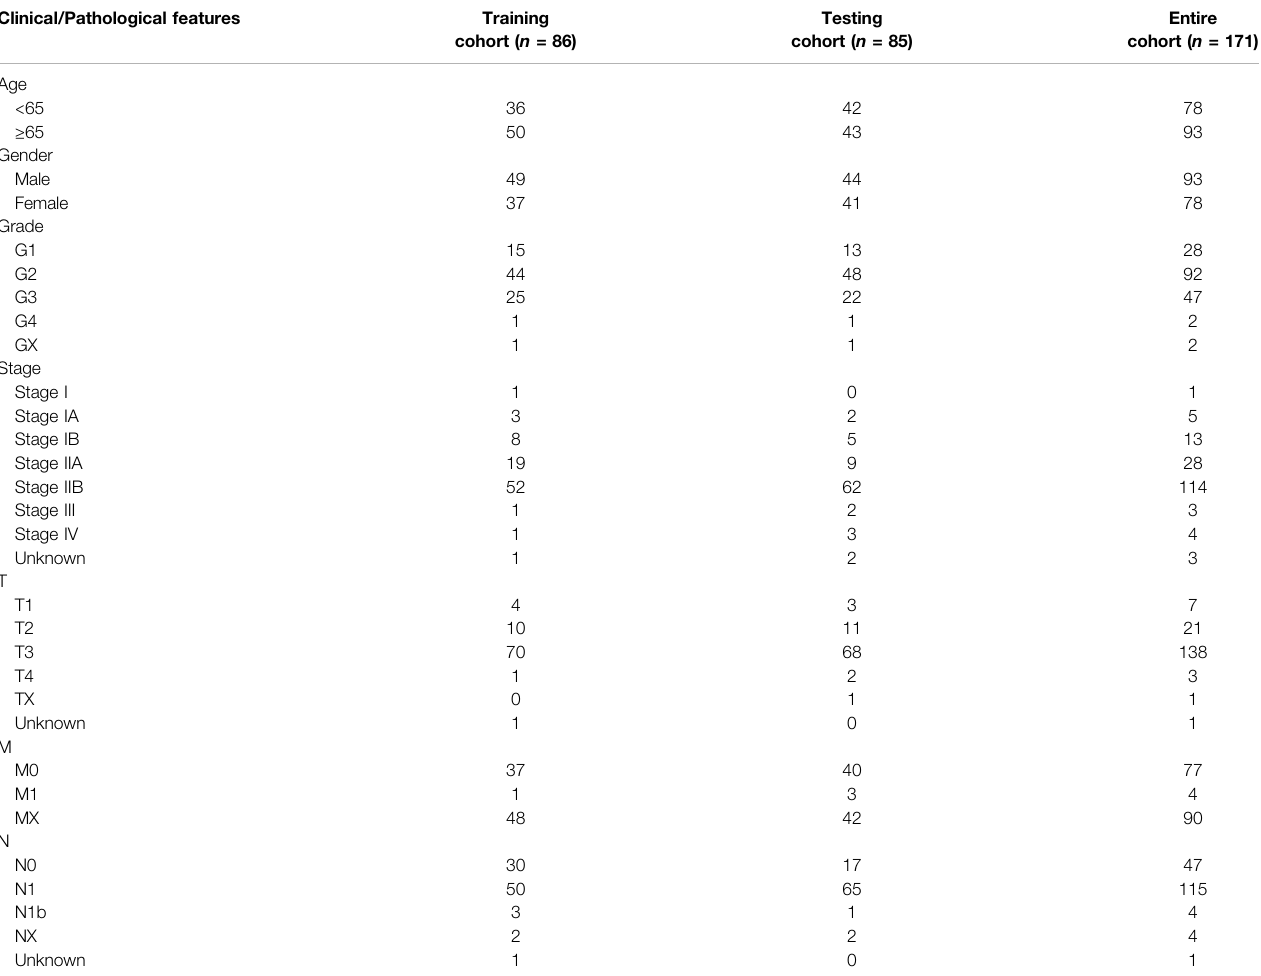
TABLE 1 | Baseline table for TCGA-PAAD. Clinical/Pathological